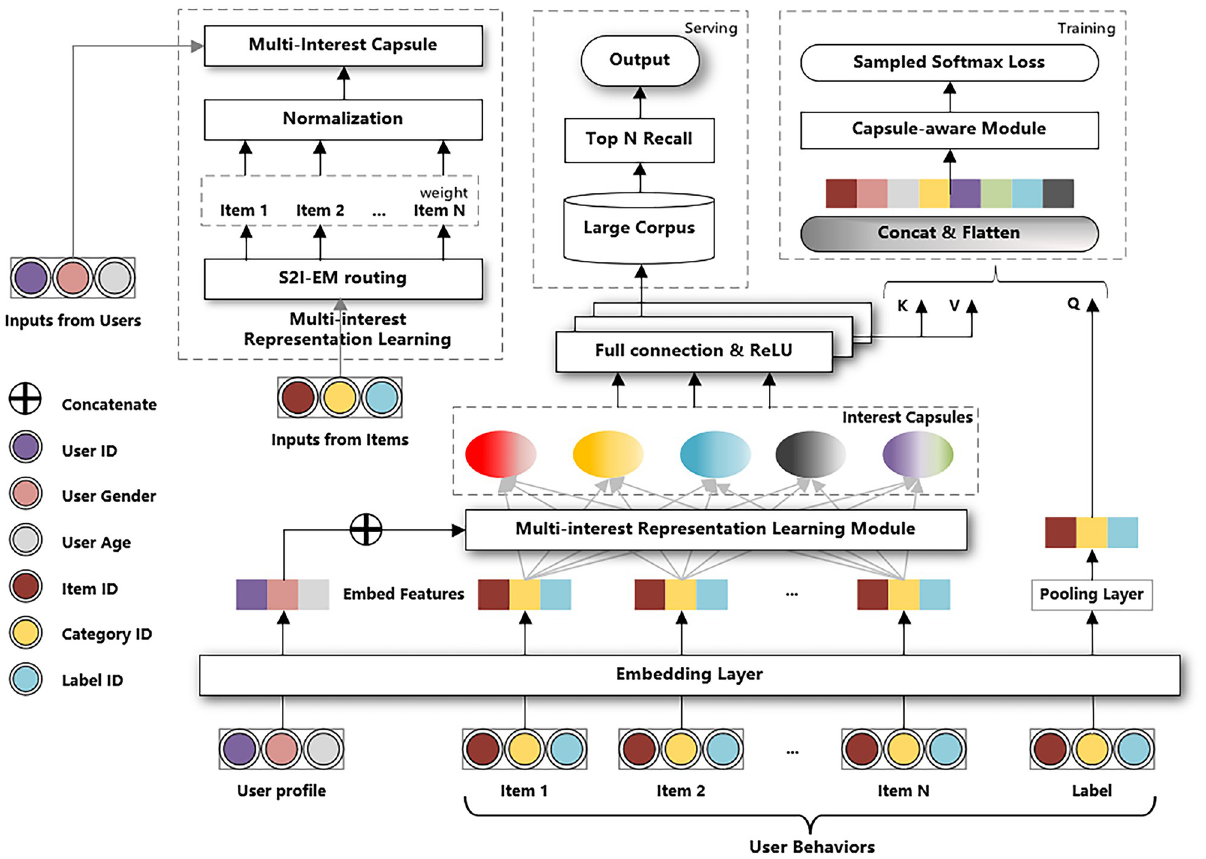
Fig 2. Network structure of MIRN. MIRN takes a sequence of user profile features and user behaviors as input and outputs multiple user representation vectors for item retrieval. User behaviors and other user features (gender, age, etc.) are fed to the multi-interest representation learning module through the corresponding operations (feature embedding and average pooling) of the embedding module. Then, the interest Capsules generated by the multi-interest representation learning module are stitched with the user’s other feature embeddings separately, and multiple user representation vectors are obtained through several Full connection & ReLU layers. Finally, multiple user representation vectors are used in parallel for Top N item retrieval. The Capsule-aware module is mainly used to guide the training of the model.